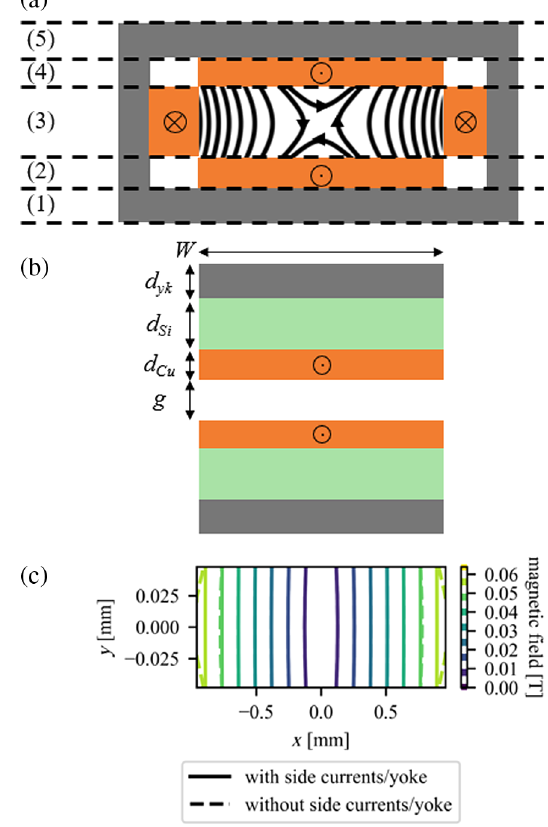
FIG. 2. (a) Depiction of PQ and its magnetic field contours. The current sheets are orange and are surrounded by the gray magnetic yoke. The microfabrication layers are delineated with dashed lines. (b) The cross section of the MPQ, showing the device geometry parameters ( L is not shown but is simply the extrusion length of the cross section into the page). Orange is copper, green is silicon, and gray is the magnetic yoke. (c) The magnitude of the transverse magnetic field of a relatively wide PQ ( W ¼ 2 mm and g ¼ 0 . 1 mm) with side currents and yokes (solid lines) and without (dashed lines). All appreciable variation is at the edges of the bore